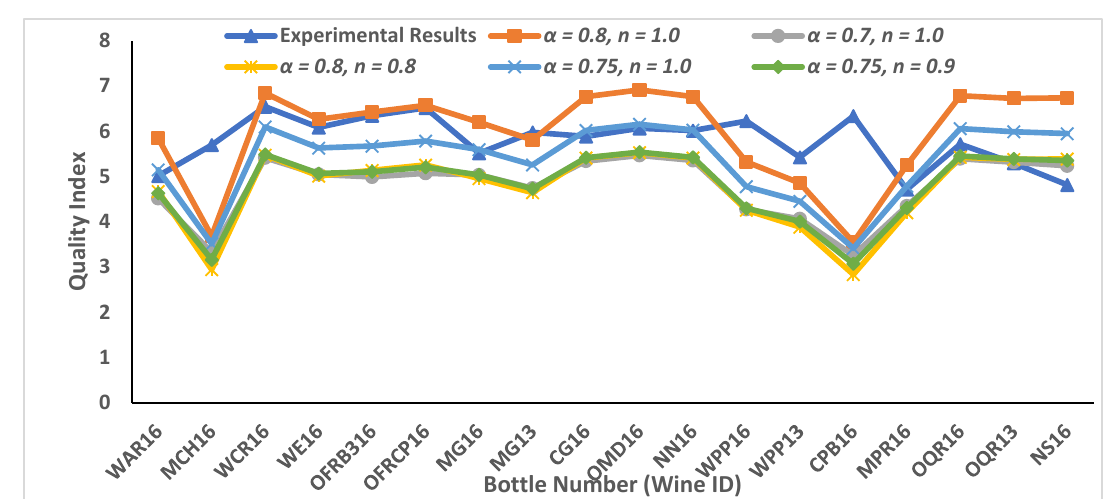
Figure 6. Predicted wine quality values for Pinot noir wines with available experimental results. Five sets of parameters were used for comparative study of available New Zealand Pinot noir wine samples with available sensory results from Experiment 1. Different values of two parameters α and n were used for understanding the impact of different essential modulators on the overall quality value.